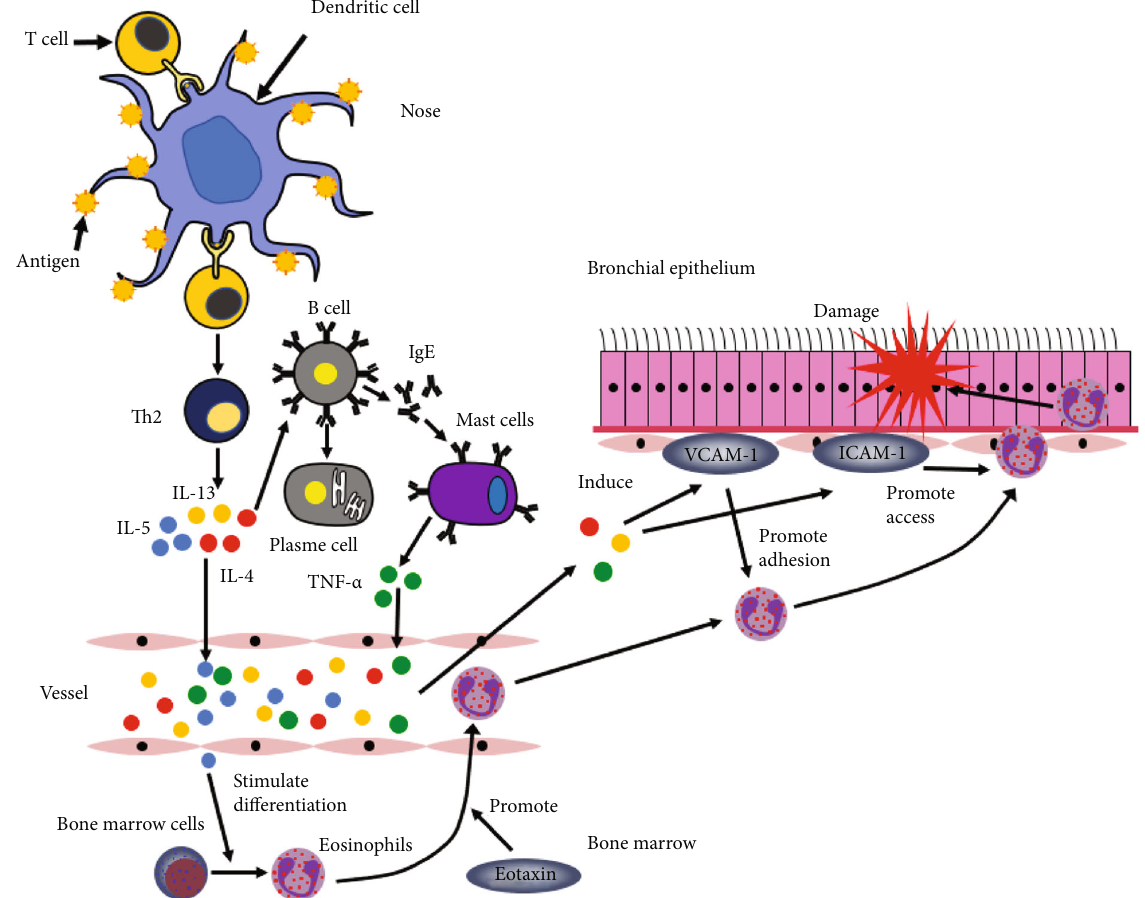
Figure 1: After the upper airway is stimulated by allergens, the in fl ammatory factors and cytokines produced by the upper airway cause the aggregation of eosinophils in the lower airway, which causes the hyperresponsiveness of the lower